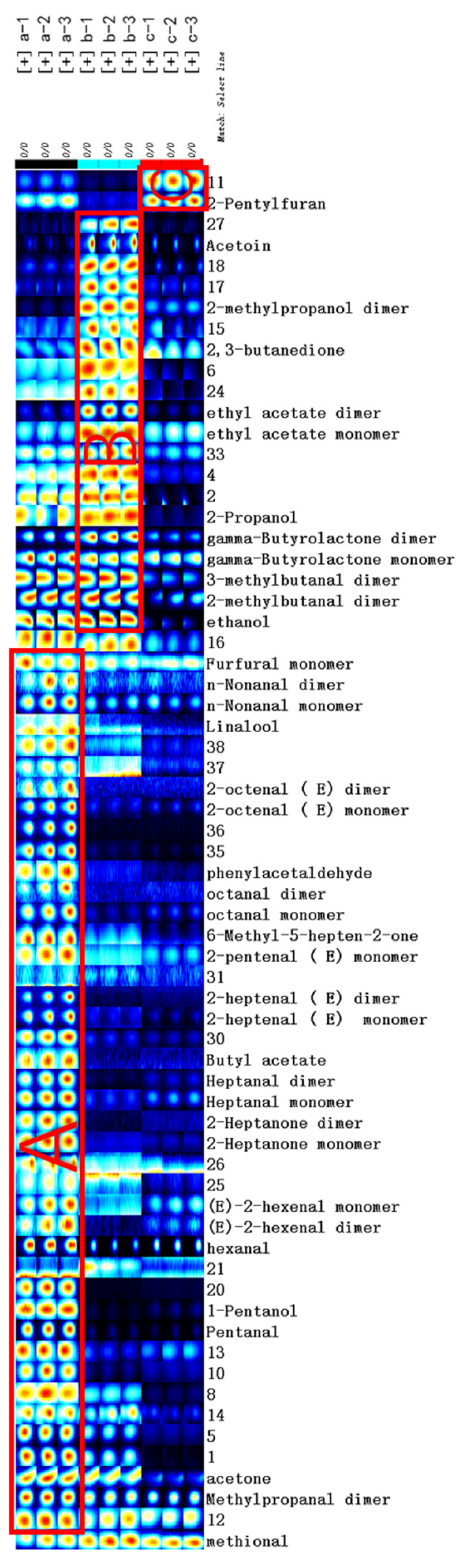
Figure 4. Fingerprint of VOCs of different cistanches. a: Oil cistanche, b: blood cistanche, c: cistanche tubulosa in